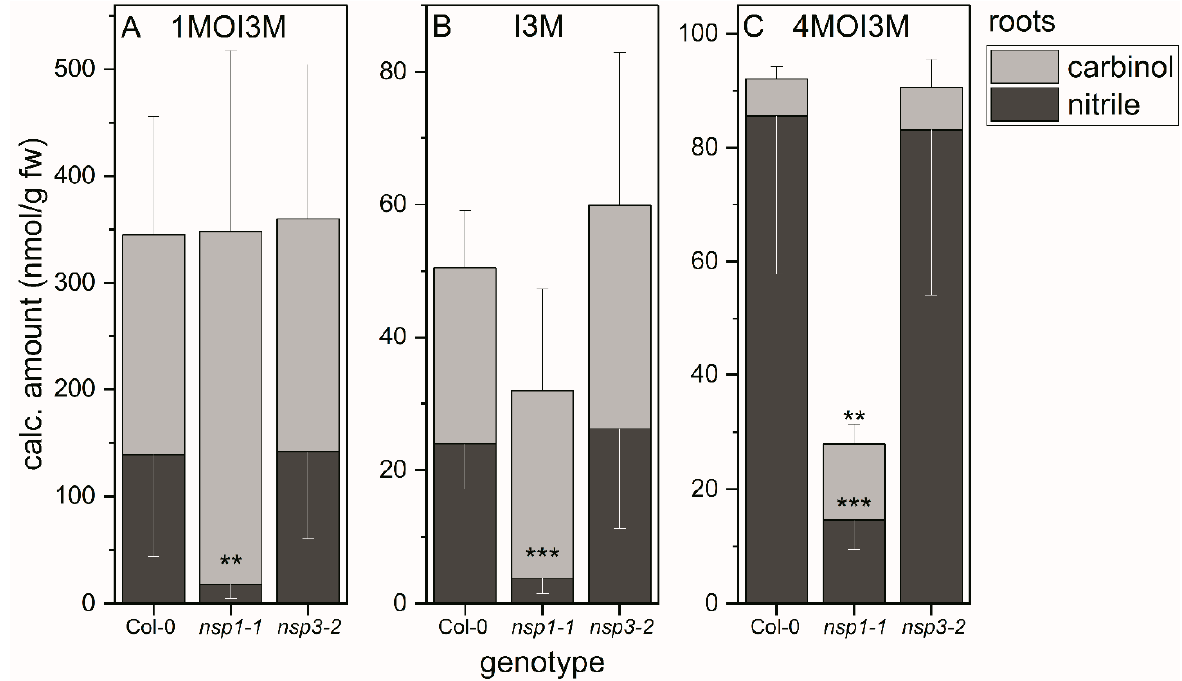
Figure 4. Breakdown of indole glucosinolates in homogenates of roots of WT, as well as nsp1-1 and nsp3-2 mutant plants. Absolute amounts of carbinols and nitriles derived from indole glucosinolates 1MOI3M ( A ), I3M ( B ) and 4MOI3M ( C ) relative to root fresh weight. Means ± SD of N = 6 independent experiments (one sample composed of roots from six plants per experiment). Significant differences between wild-type and mutants are indicated separately for each carbinol and nitrile by asterisks (**, p <0.01; ***, p < 0.001; two-sample t -test; Mann–Whitney test when normal distribution could not be